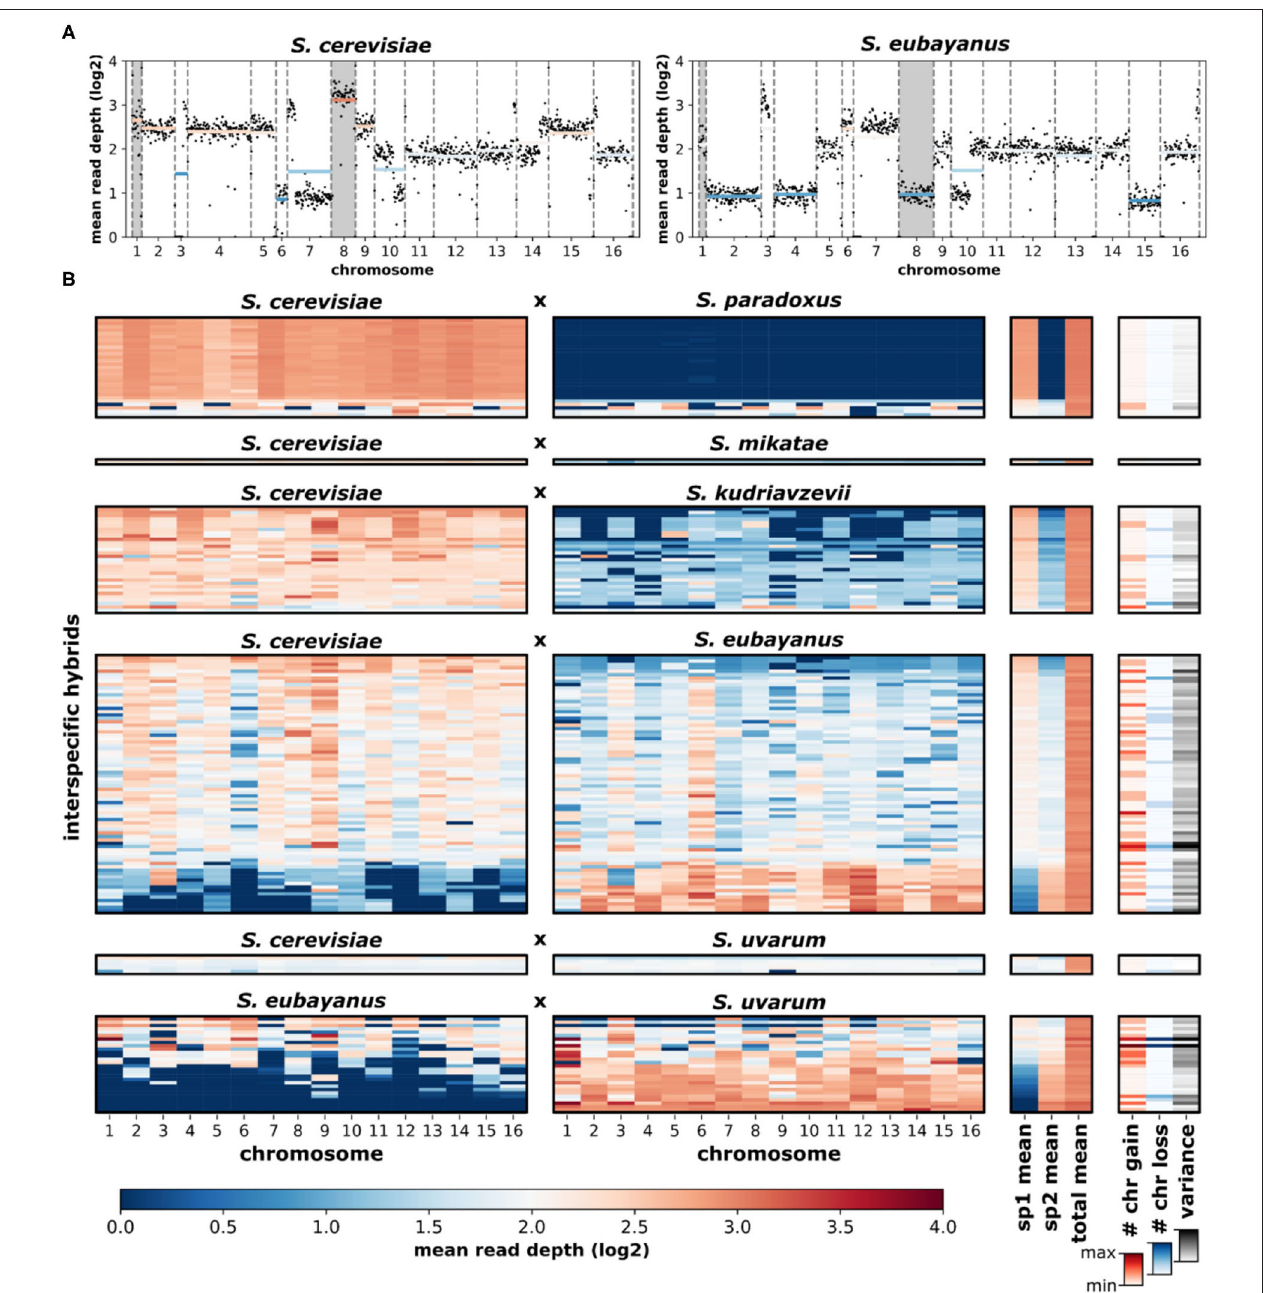
FIGURE 5 | Sequencing read depth of Saccharomyces interspecific hybrids. (A) An example of a hybrid (CBS1483) with reads mapped to the putative parental species, S. cerevisiae and S. eubayanus . Black dots indicate the read depth of ∼ 10 kbp windows. Dashed vertical lines separate chromosomes. Horizontal colored lines indicate mean chromosomal read depth. Chromosomes with elevated read depths (aneuploidy) are indicated with gray backgrounds. (B) Mean chromosomal read depths of 170 hybrid genomes. Rows are individual hybrid genomes. Genomes are presented in the same order as Figure 3 and are grouped by hybrid cross. Genome-wide read depth means for each parental species (sp1, sp2) and the total (sp1 + sp2) genome-wide mean are shown. The number of high (# chr gain) and low (# chr loss) read depth chromosomes were defined as chromosomes with a mean read depth 30% higher or lower than the genome-wide mean. Chromosomal read-depth variance was calculated as the variance (s 2 ) of the genome-wide mean.